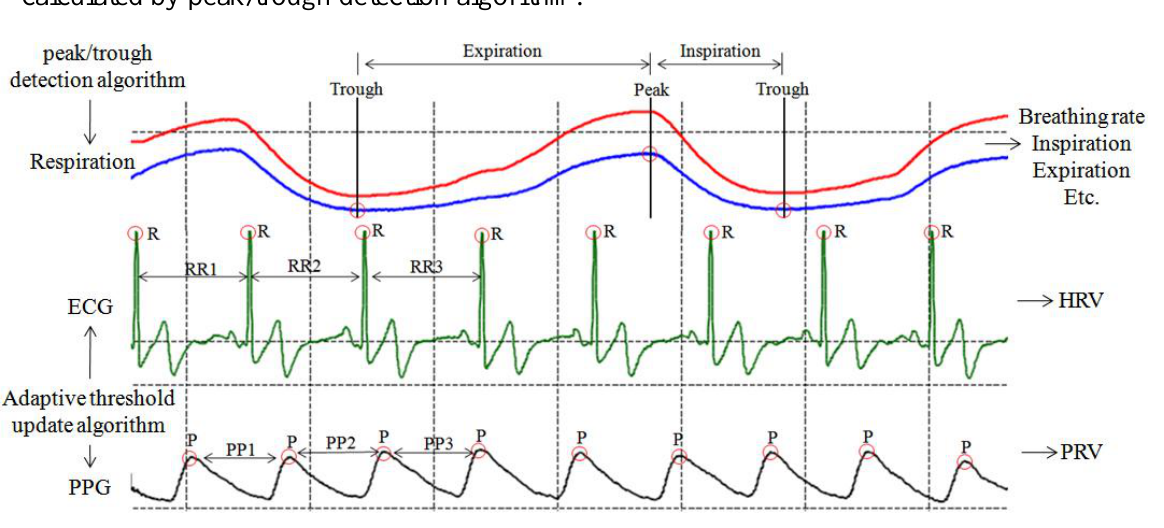
Figure 6. The characteristic values of ECG, PPG and respiration signal. HRV and PRV signal are extracted by adaptive threshold update algorithm, and respiration parameters are calculated by peak/trough detection algorithm.